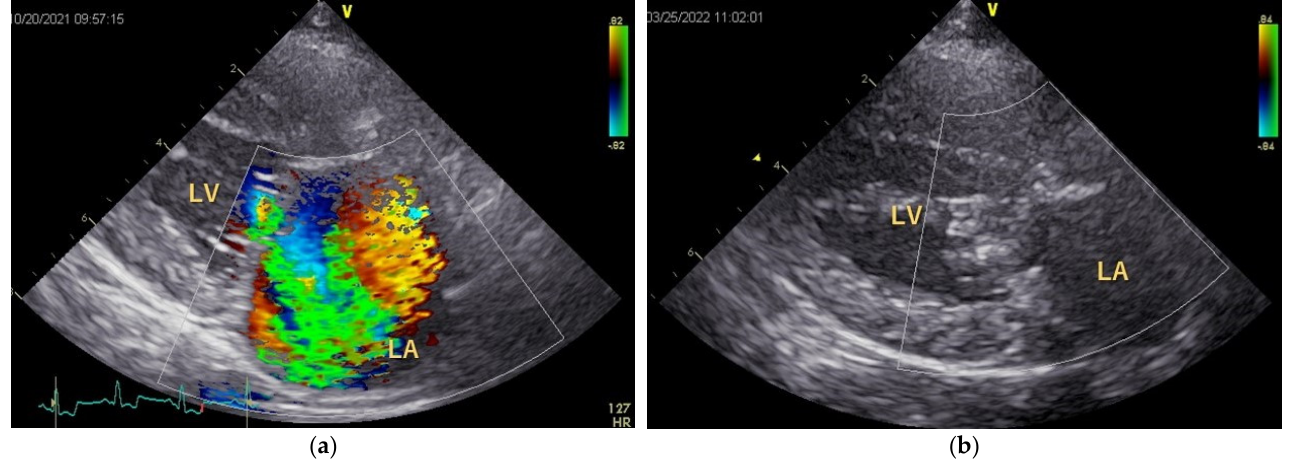
Figure 4. Color Doppler echocardiography. ( a ) Preoperative parasternal four-chamber view showing large turbulence mosaic patterns from the left ventricle to the left atrium, indicating the presence of severe MR. ( b ) Postoperative parasternal four-chamber view shows the disappearance of MR and reduction in the left atrial size. LA: left atrium; LV: left ventricle.